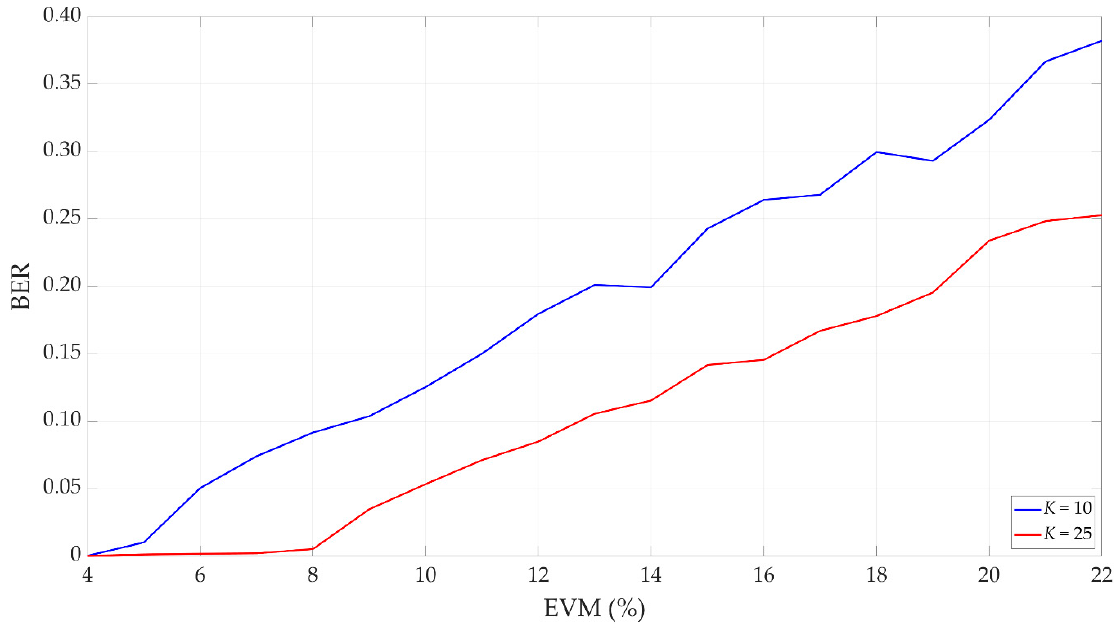
Figure 19. Covert signal detection results: BER versus EVM for selected K .